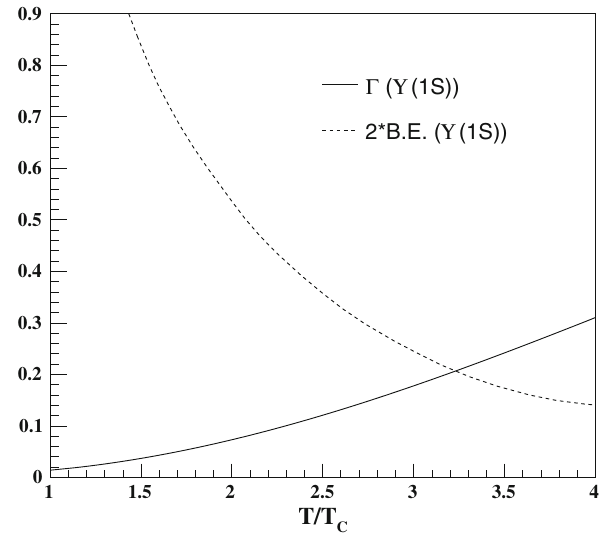
Fig. 18 Variation of two times of binding energy of ϒ( 1 S ) and decay width with respect to T / T